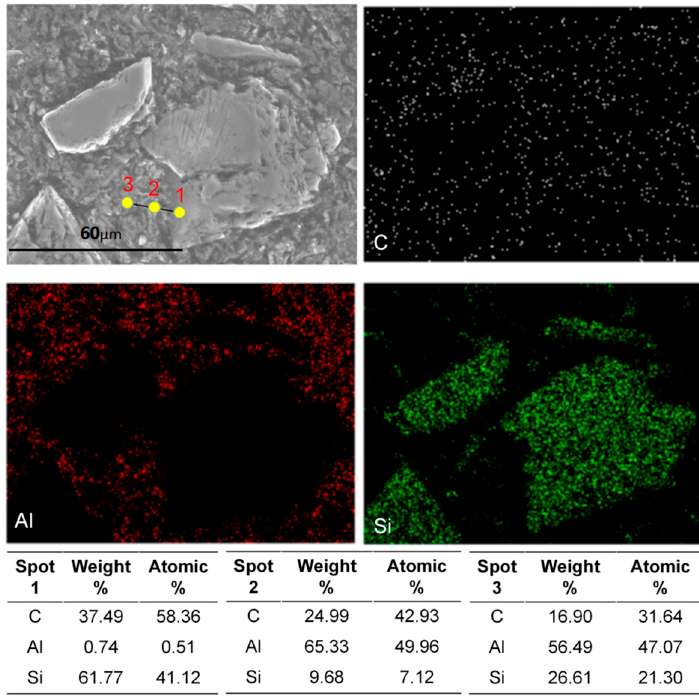
Figure 13. SEM image and EDS mapping analysis of Al-30Si-10C(G1)-5SiC.